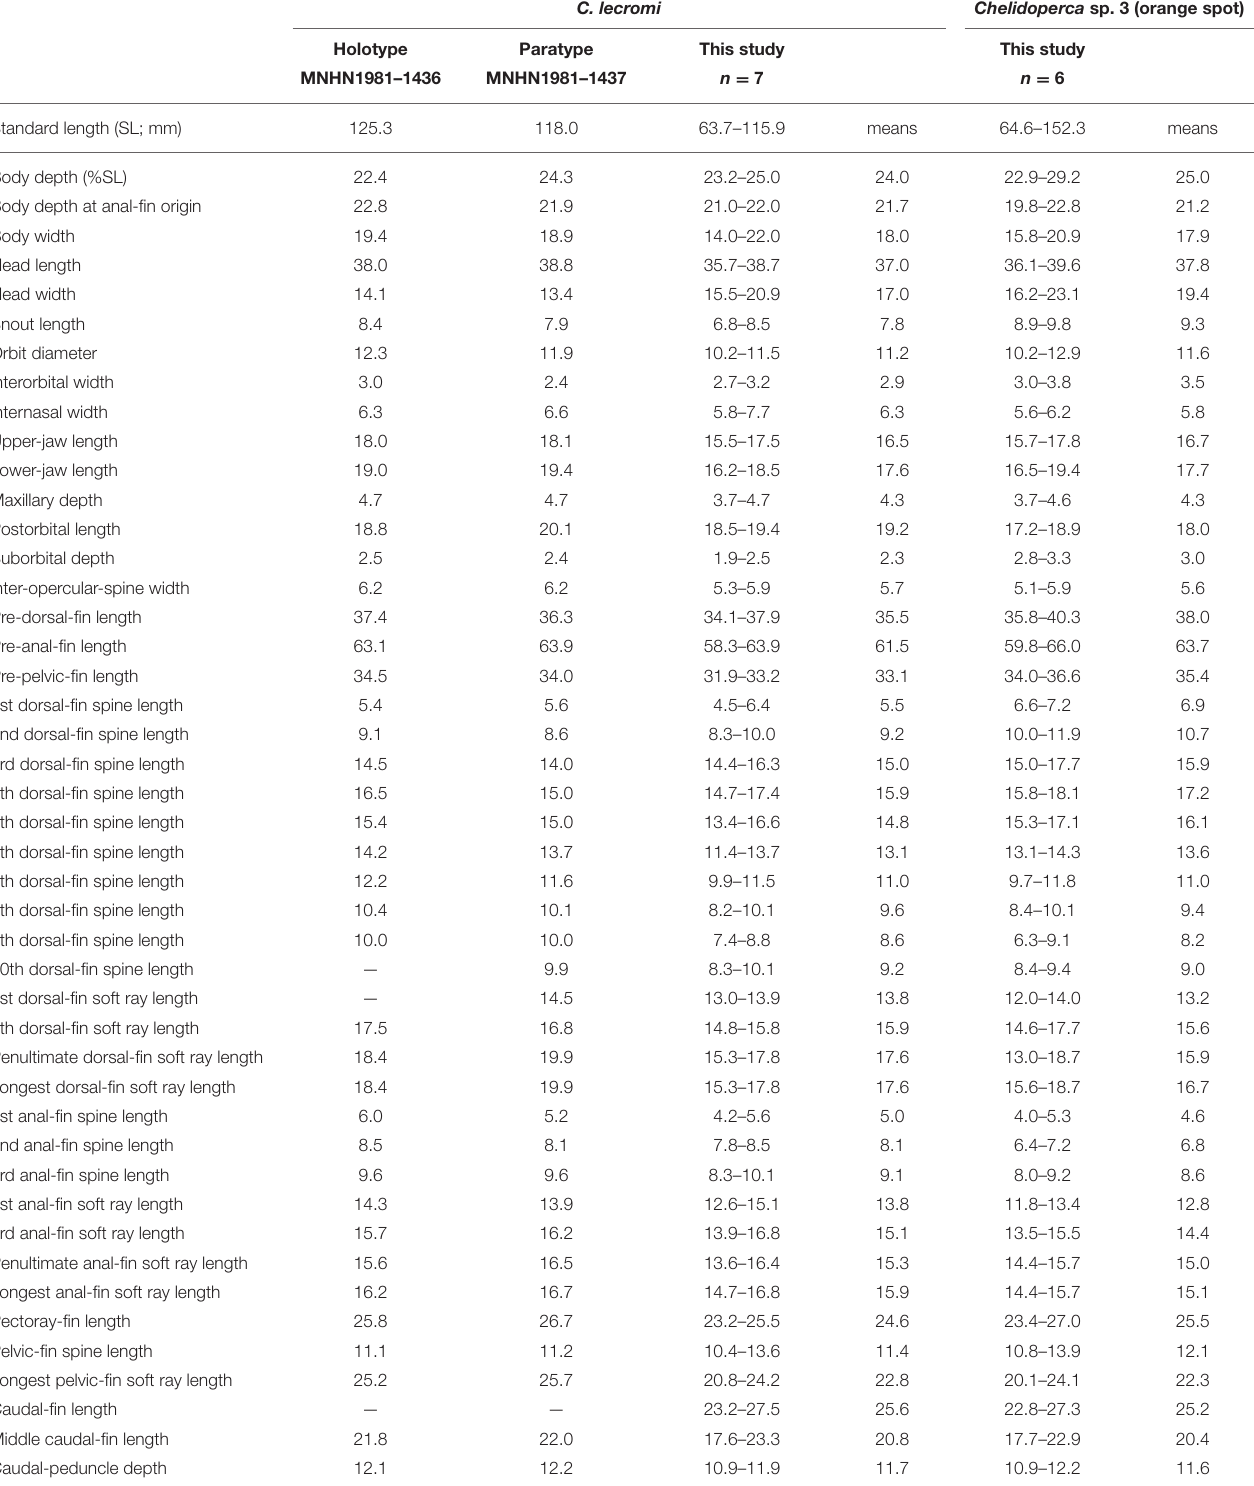
TABLE 8 | Mophometrics expressed as percentages of the standard length from Chelidoperca lecromi (including examined specimens and references data) and Chelidoperca sp. 3 (orange